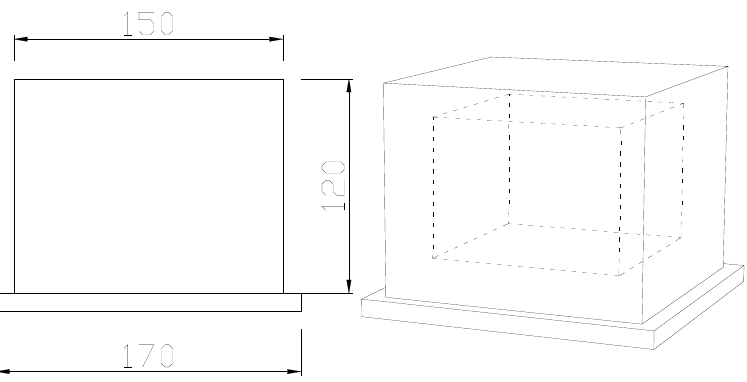
Figure 3. Test specimens for the friction test.